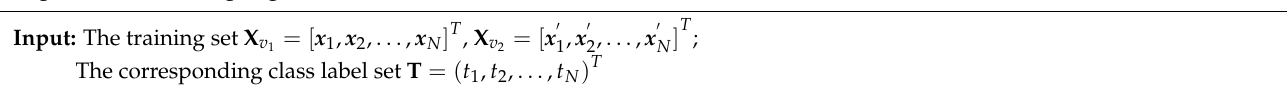
Algorithm 1: Training Algorithm Of